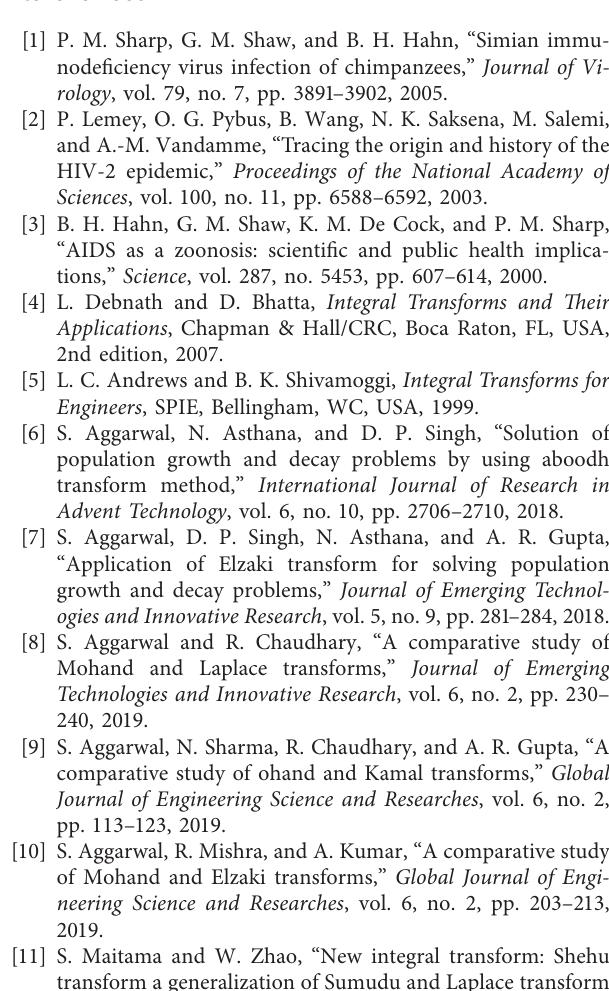
Table 9: Inverse Shehu transformation of frequently used functions [12–14].